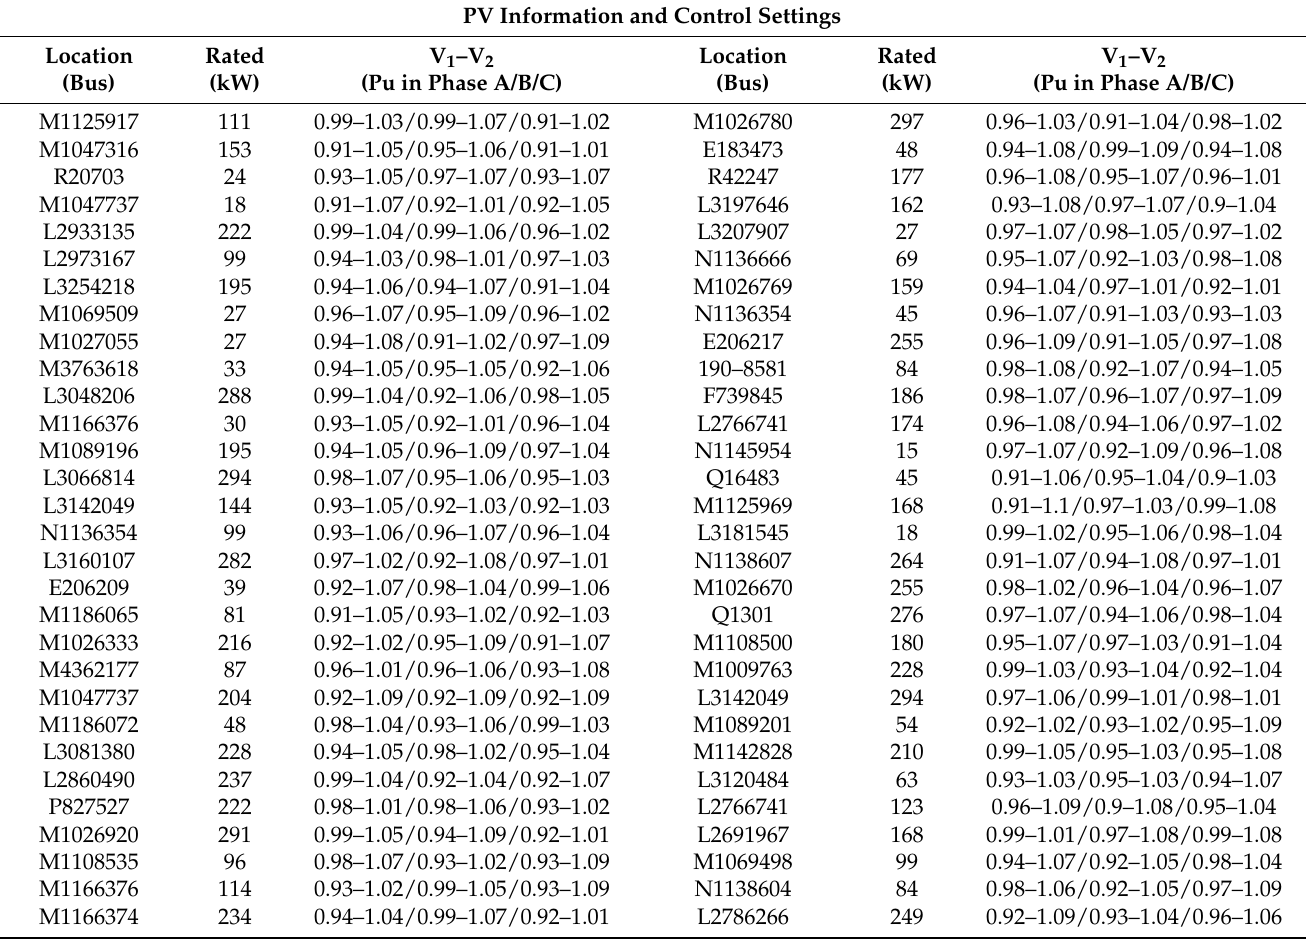
Table 5. The volt–var control settings of each PV smart